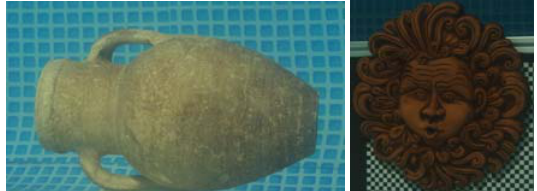
Table 1. Mean values of intrinsic parameters of left and right camera in water and air.